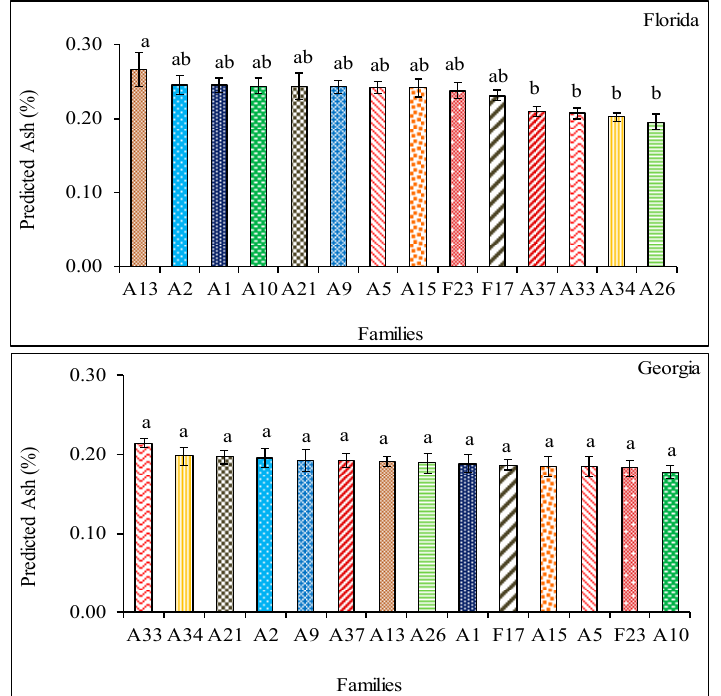
Figure 4. Rank of loblolly pine families for ash content. * Bars with different letters are significantly different at 95% confidence level (Tukey’s HSD Test).